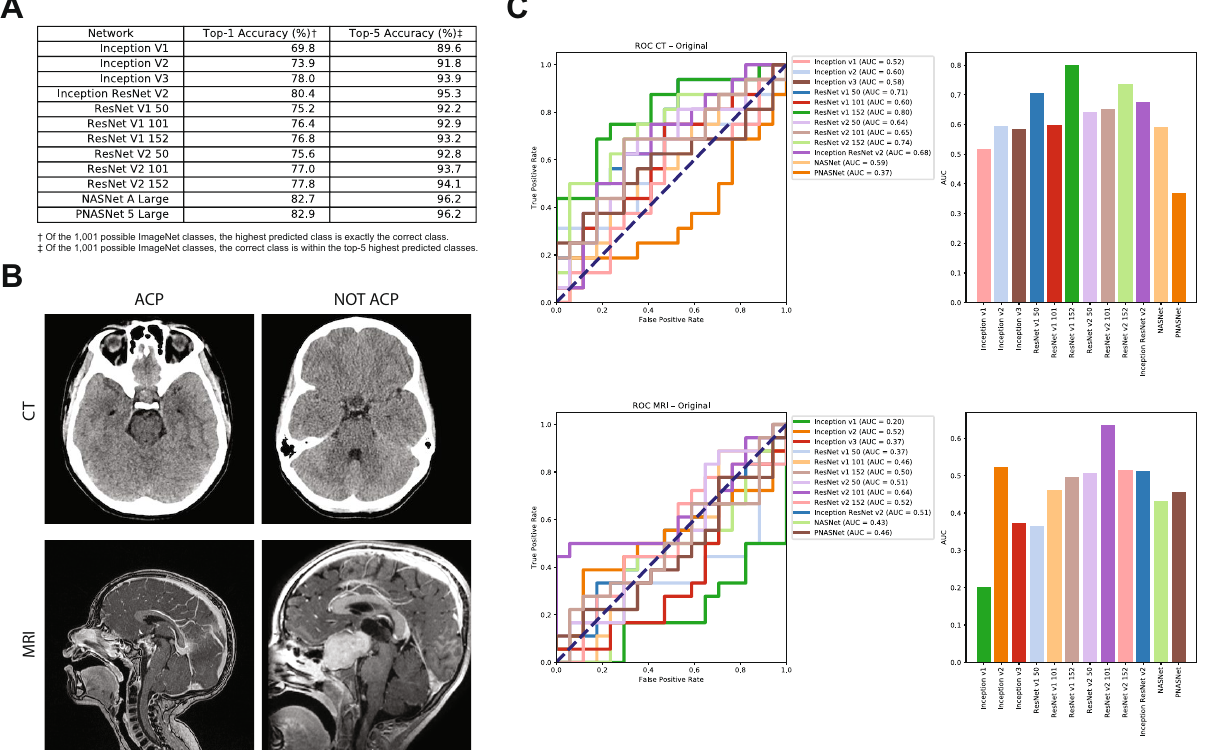
Figure 1. Transfer learning networks, feature embeddings, and baseline results. ( A ) ILSVRC network models utilized, with their top 1% and top 5% accuracy in ILSVRC competition noted. ( B ) Example CT and MRI images for both ACP and NOTACP. ( C ) ROC (left) and AUC (right) values for all twelve networks and both imaging modalities (CT top, MRI bottom). The diagonal dashed line represents performance of a random